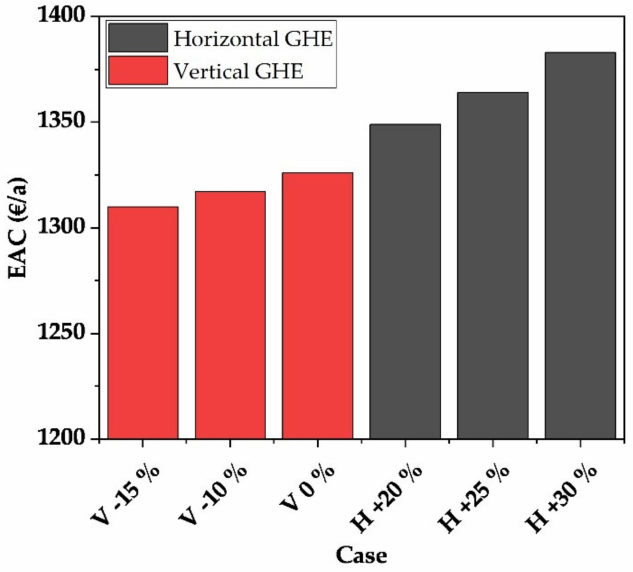
Figure 12. Total cost for heating and cooling per consumer for each case in the region of